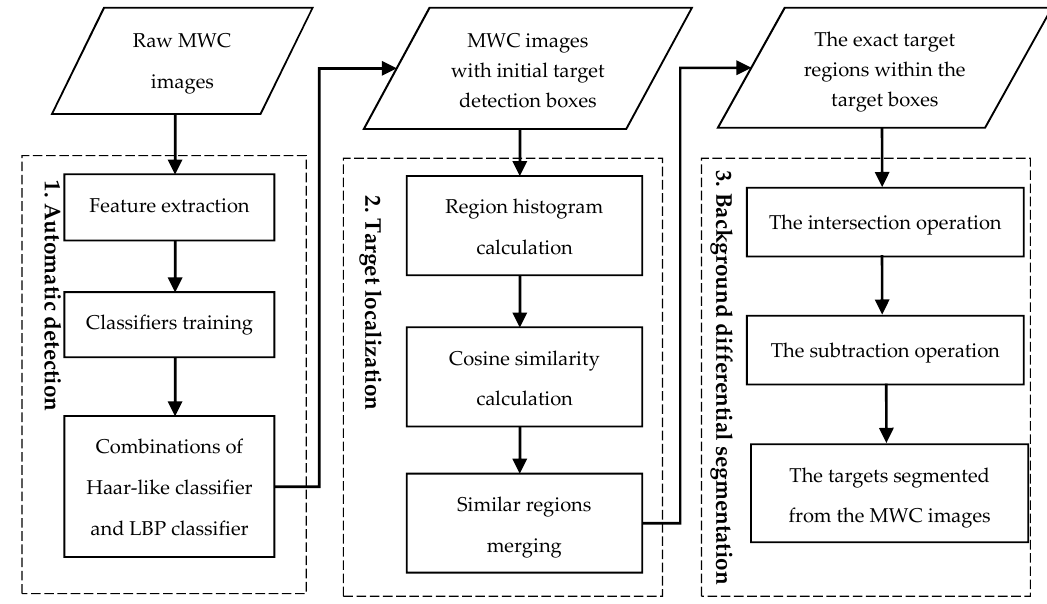
Figure 2. Automatic gas plumes detection and segmentation method.